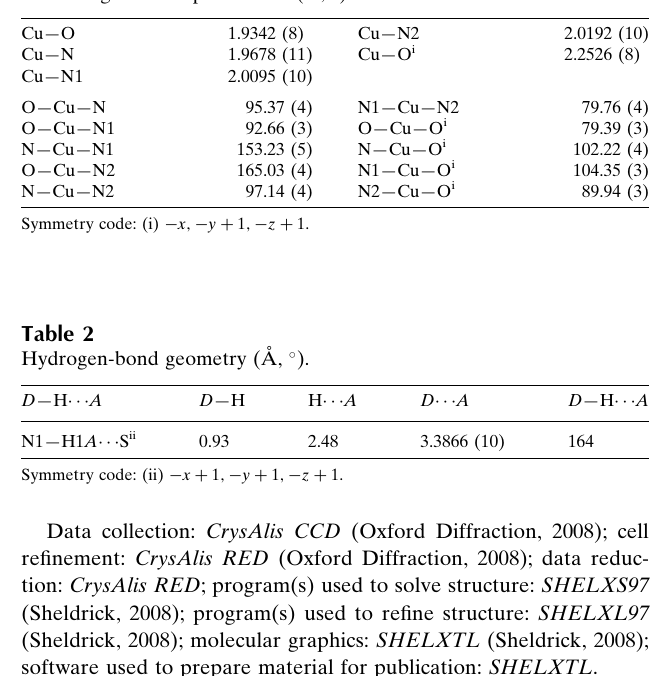
Selected geometric parameters (A˚ , (cid:3) ).